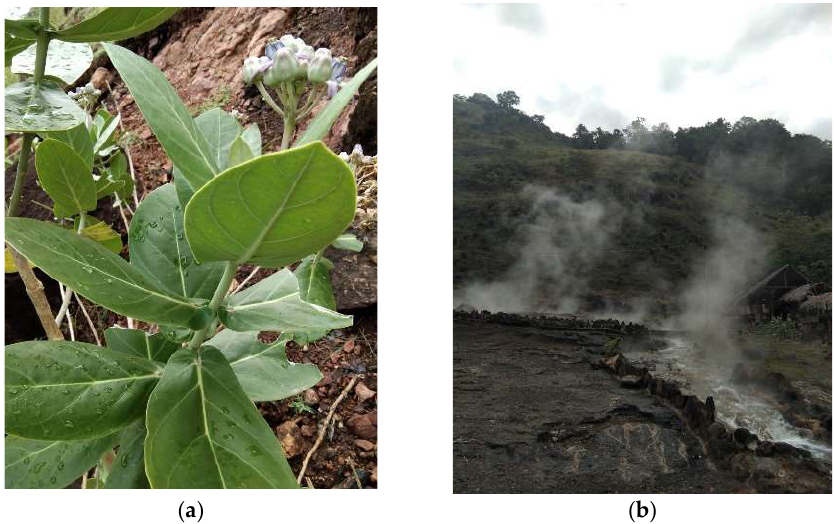
Figure 7. ( a ) C. gigantea plant; and ( b ) Ie Seu-Um geothermal manifestation area.